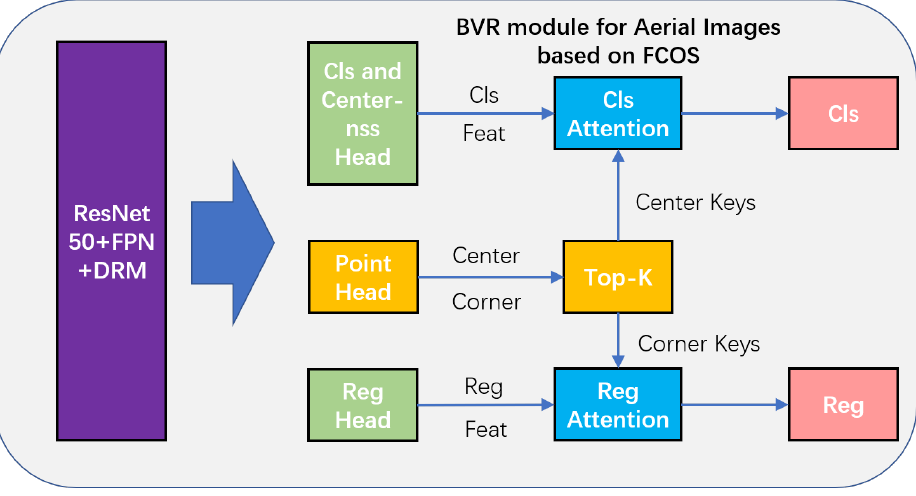
Figure 7. The construction process for the BVR module based on